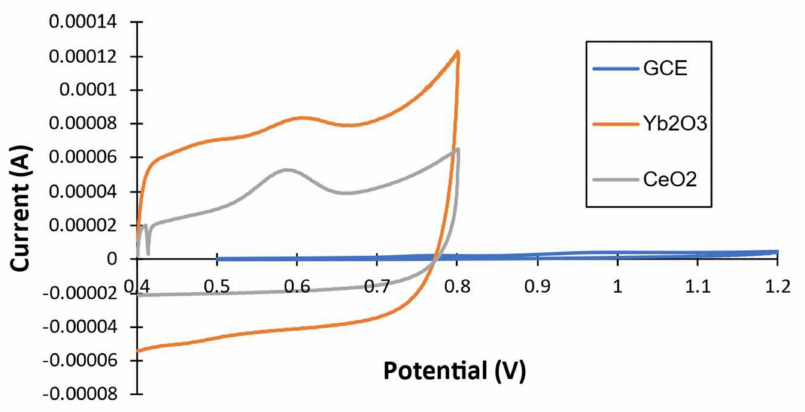
Figure 7. Voltammograms for electrochemical analysis of SFX using GCE electrode, MWCNTs- CeO 2 @GCE electrode and MWCNTs-Yb 2 O 3 @GCE electrode in phosphate buffer solution, pH = 7.0 at 50 mV · s − 1 for 20 µ M. Experimental conditions: counter electrode: Pt, reference electrode: Ag/AgCl;